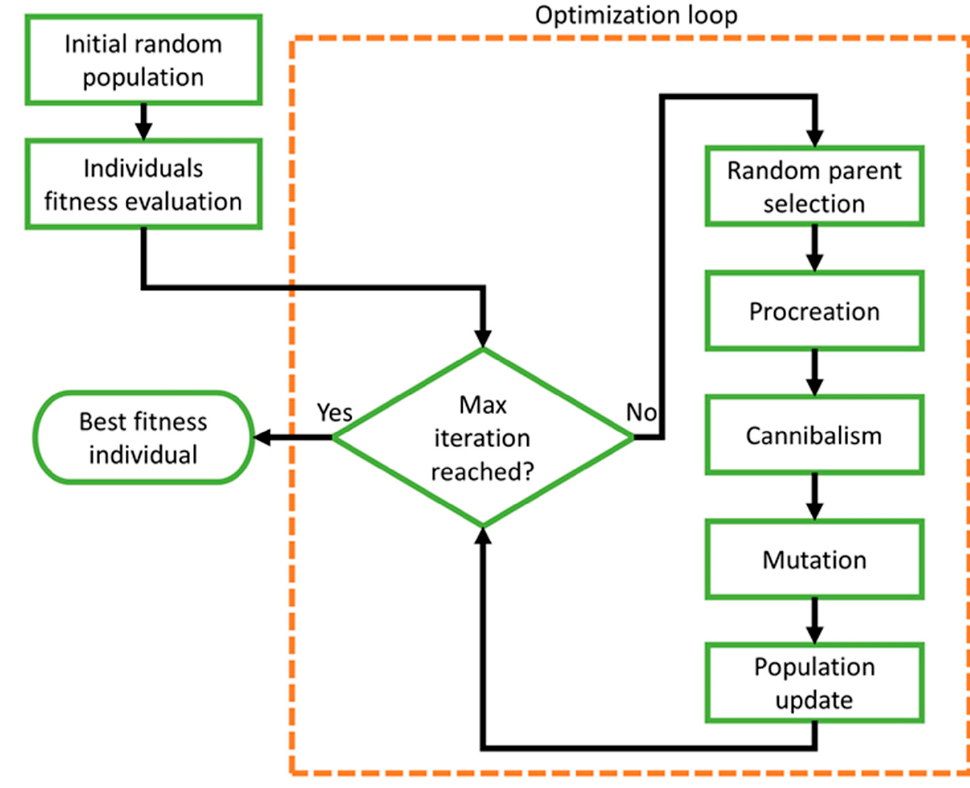
Figure 8. Black Widow Optimization (BWO) algorithm.